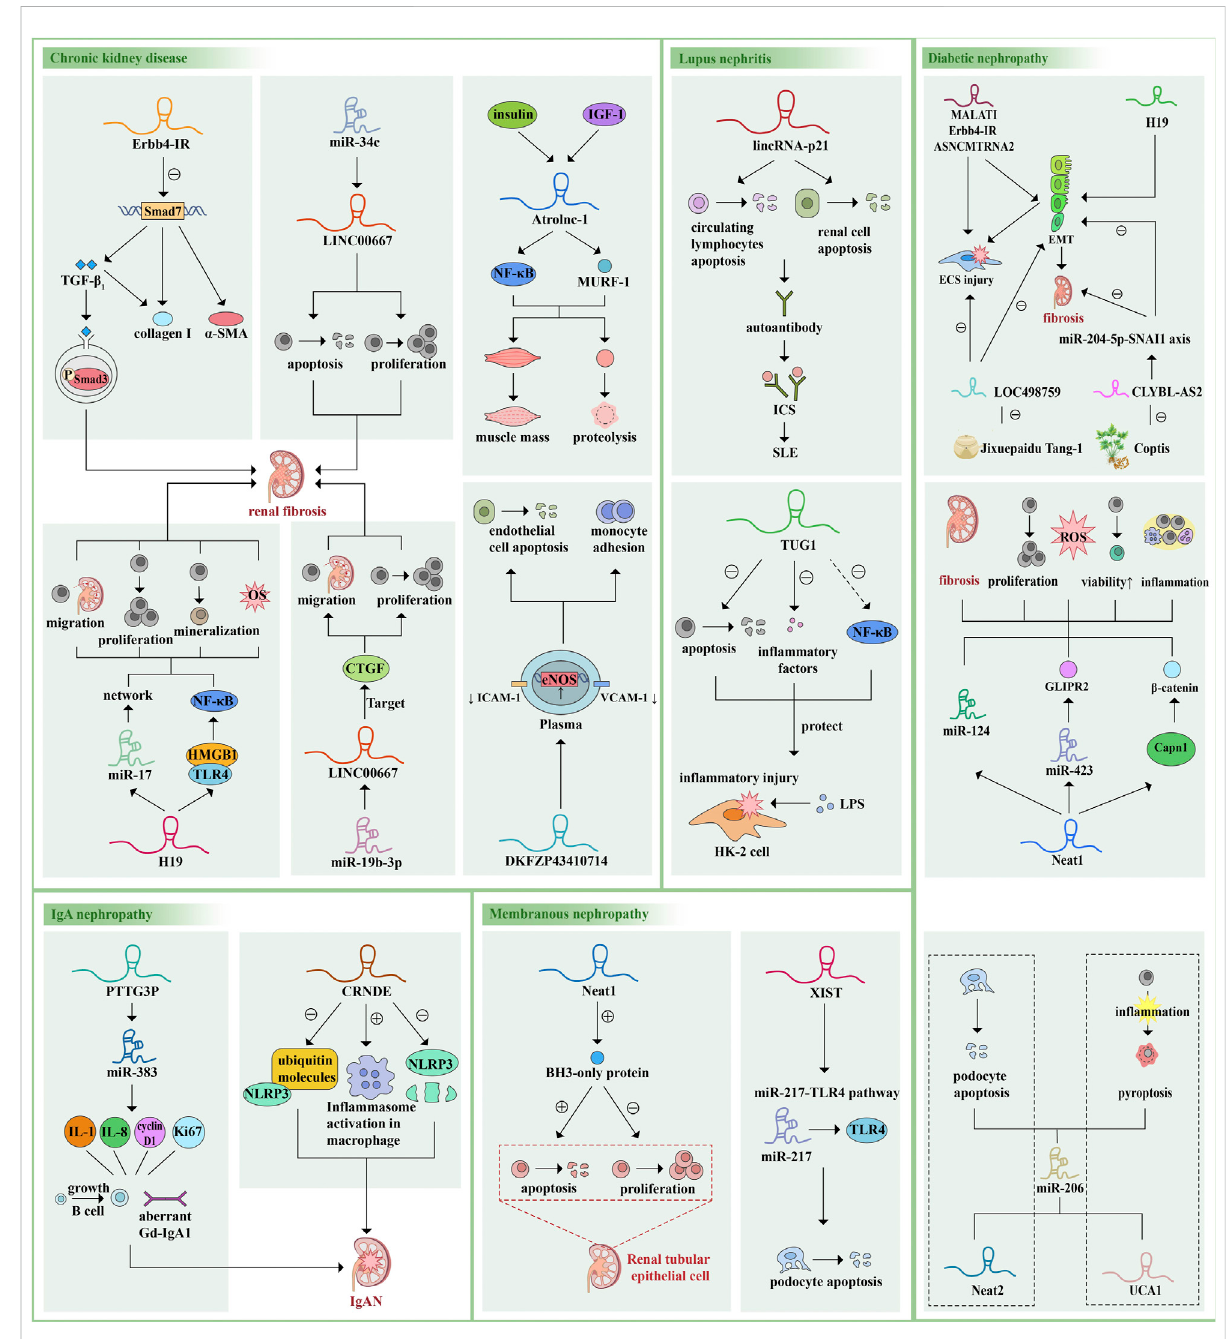
FIGURE 3 Examples of the roles of lncRNAs in kidney disease pathophysiology. LncRNAs are mainly involved in the occurrence and development of various kidney diseases by regulating downstream miRNAs or genes, regulating different pathways and signal transduction axis, sponging miRNAs and changing protein molecules and cytokine levels, thus regulating cell proliferation, apoptosis, pyroptosis, migration, oxidative stress, EMC and changing cell vitality. Here we give some more studied examples of lncRNAs and their mechanisms of action and functions. The same lncRNA can be involved in different diseases and act on different pathways or miRNAs. Different lncRNAs can also act on the same downstream target, formingavastregulatorynetwork. α -SMA,alpha-smooth muscleactin;TGF- β ,transforminggrowthfactor- β ;IGF-1,insulinlikegrowthfactor-1;NF- κ B, nuclear factor kappa B; MURF-1, muscle ring fi nger 1; HMGB1, high mobility group box 1; TLR4, Toll-like receptor 4; CTGF, connective tissue growth factor; ICAM-1, intracellular adhesion molecule 1; VCAM-1, vascular cells adhesion molecule 1; eNOS, endothelial nitric oxide synthase; ICs, immune complexes; SLE, systemic lupus erythematosus; LPS, lipopolysaccharide; IL, interleukin; Gd-lgA1, galactose-de fi cient IgA1; GLIPR2, Glioma pathogenesis